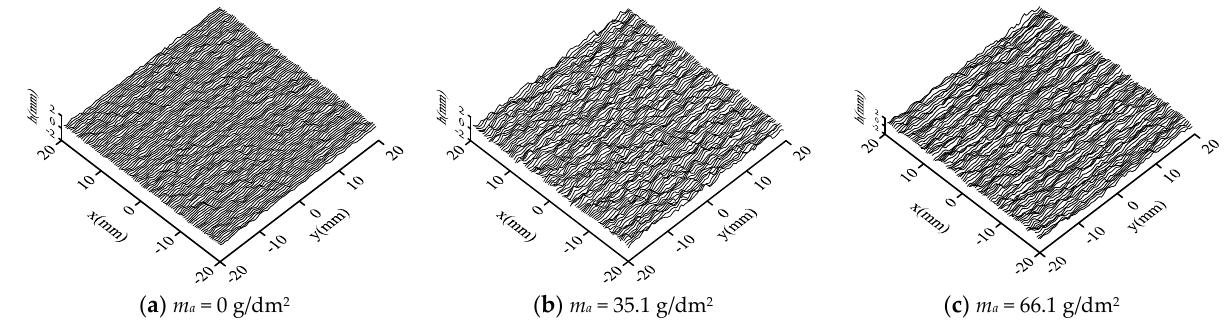
Figure 16. Randomly generated corroded surface with different corrosion